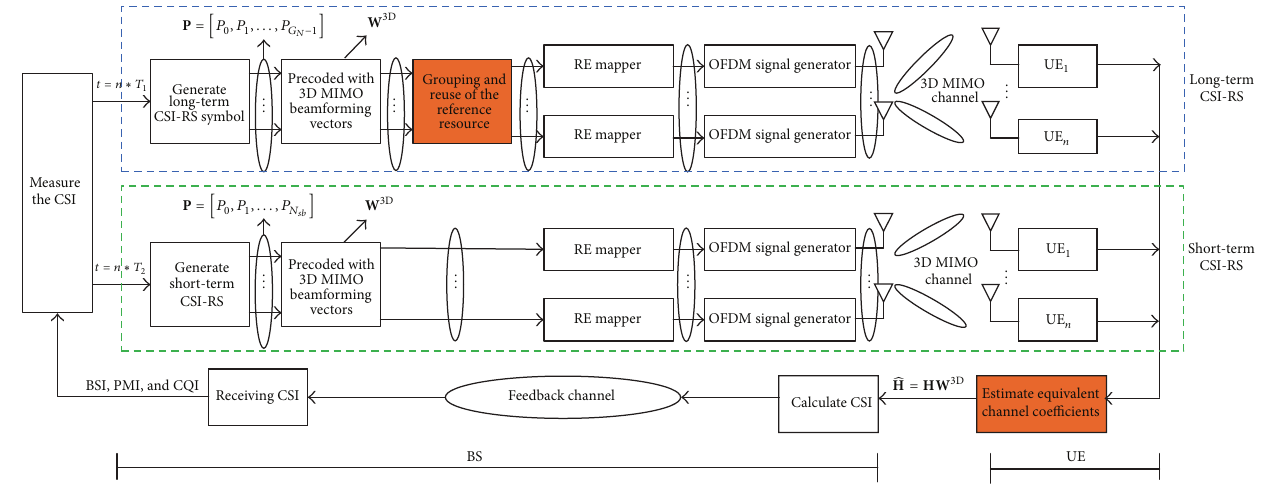
Figure 4: Block diagram of transmitting CSI-RS and measuring the corresponding